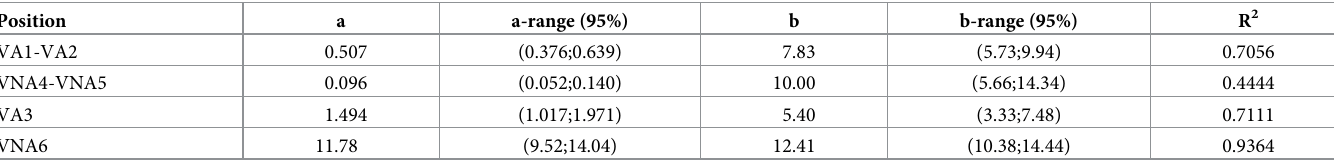
Based on this correlation matrix, a dose-response function (DRF) that correlates meteoro- logical parameters and the biological colonization on vertical surfaces was developed. On hori- zontal surfaces, contamination can occur. It was also decided to focus on green algae concentration as cyanobacteria concentration is relatively similar. The dataset is given in S1 Table. Then, the green algae concentration as a function of RH (Fig 7) was fitted using a power law and only considering the data for days without rain: green algae ½ Four sets of data were used separately: VA1 and VA2; VA3; VNA4 and VNA5; VNA6. Parameters of Eq (1) are given in Table 6. added in the DRF: